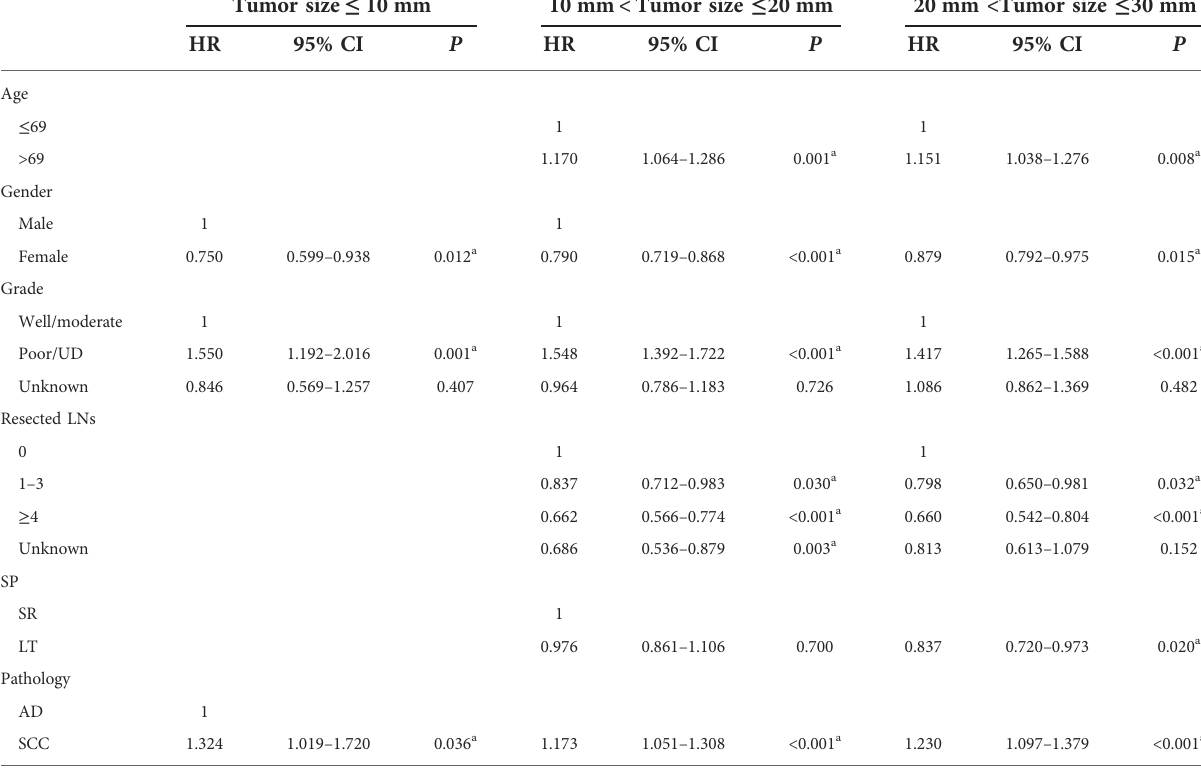
TABLE 5 Multivariate regression analyses for lung cancer – speci fi c survival strati fi ed by tumor